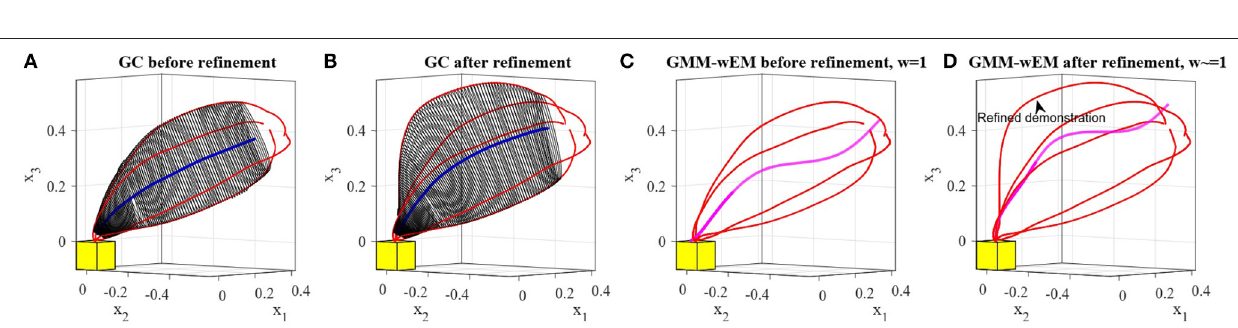
FIGURE 15 | Constraint-based refinement of a skill by correcting a reproduction. (A) Demonstrations (red), directrix (blue), and the obtained GC, (B) reproduction from a random pose (magenta), (C) refined reproduction (green), (D) two new reproductions; upper one affected by the refinement, while lower one is not.